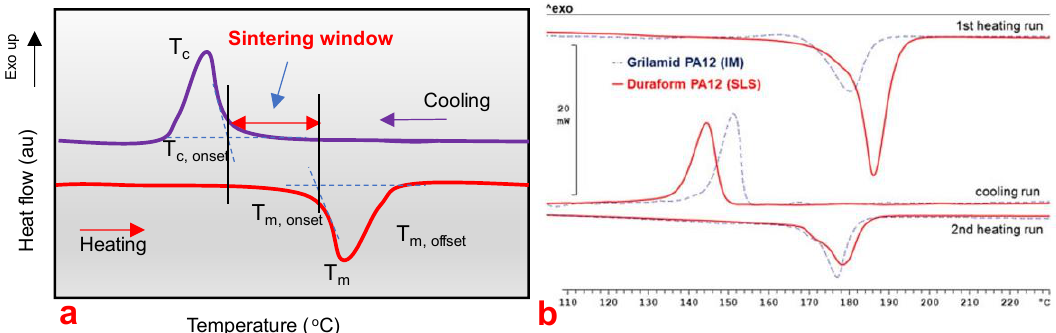
Figure 6. ( a ) Illustration of a dynamic DSC curve of a polymer. ( b ) Comparison of a commercial injection moulding PA12 grade and commercial PA12 for SLS processing, adapted from [168].